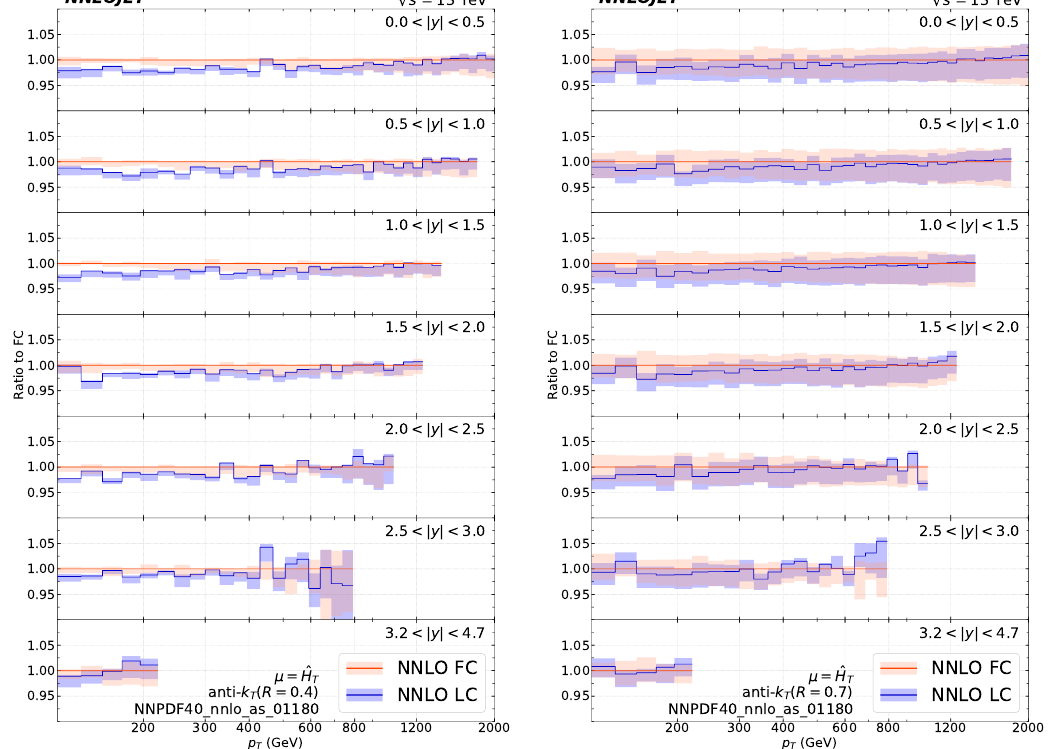
Figure 6 . NNLO LC (blue) and FC (red) predictions of the R = 0 . 4 (left) and R = 0 . 7 (right) single jet inclusive cross section as function of p T for all the considered rapidity slices, normalized to the FC